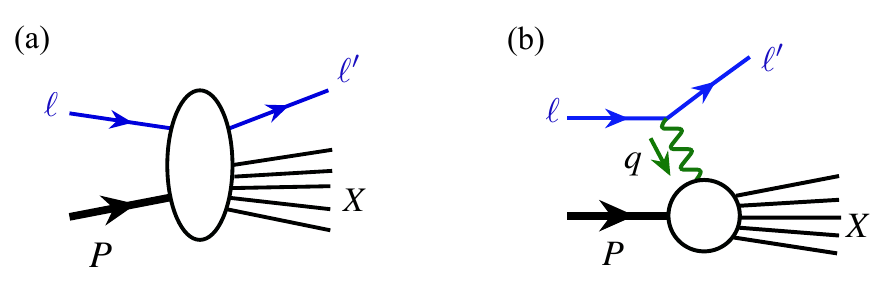
Figure 1 . (a) Inelastic scattering amplitude for a lepton ( ‘, λ ‘ ) from a nucleon ( P, S ) to a scattered lepton ( ‘ 0 ) with inclusive final states X , and (b) the same amplitude via an exchange of one virtual photon ( q